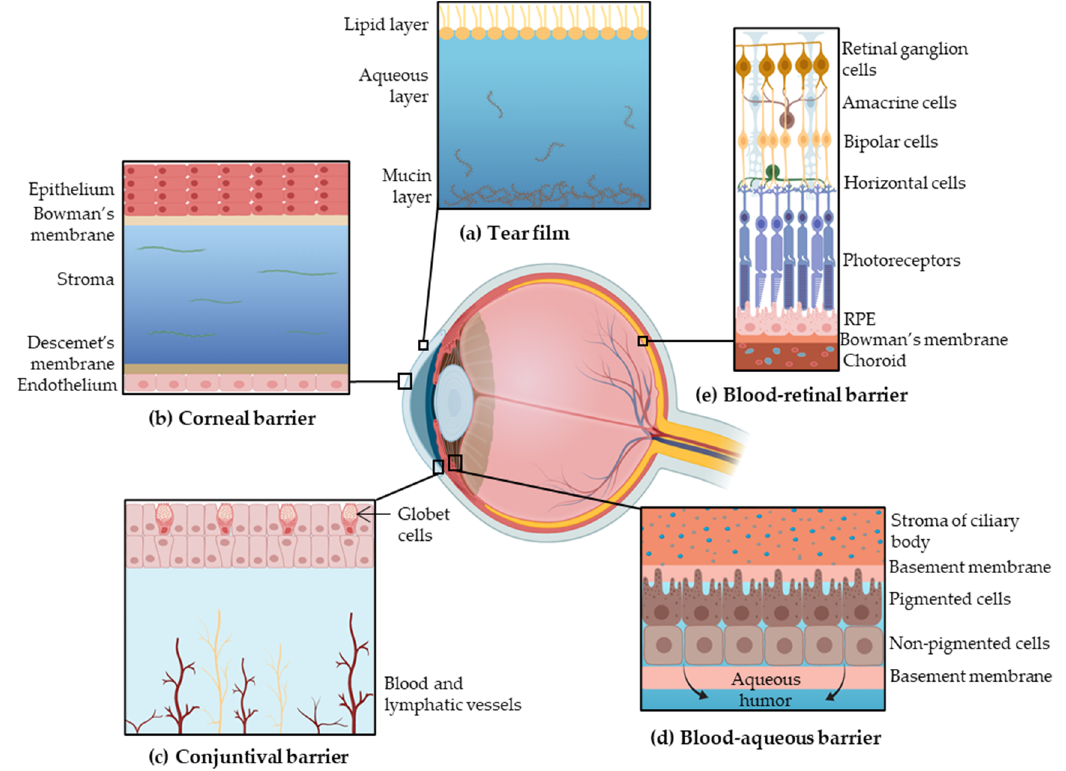
Figure 1. Barriers to ocular drug penetration: ( a ) the tear film is composed of three layers, the lipid layer, the aqueous layer and the mucin layer; ( b ) the corneal layer is formed by epithelium, Bowman’s membrane, stroma, Descemet’s membrane and endothelium; ( c ) the conjunctival barrier is vascularized; ( d ) the blood–aqueous barrier starts on the stroma of ciliary body and is composed by the basement membrane, pigmented cells, nonpigmented cells and delimited by the basement membrane; ( e ) the blood–retinal barrier is formed by the retinal ganglion cells, amacrine cells, bipolar cells, horizontal cells, both types of photoreceptors, retinal pigment epithelium (RPE) and the Bowman’s membrane. Adapted from [3,14,15], Sánchez-López, E., 2017; Farid, R.M., 2017; and Keeling, E., 2018.